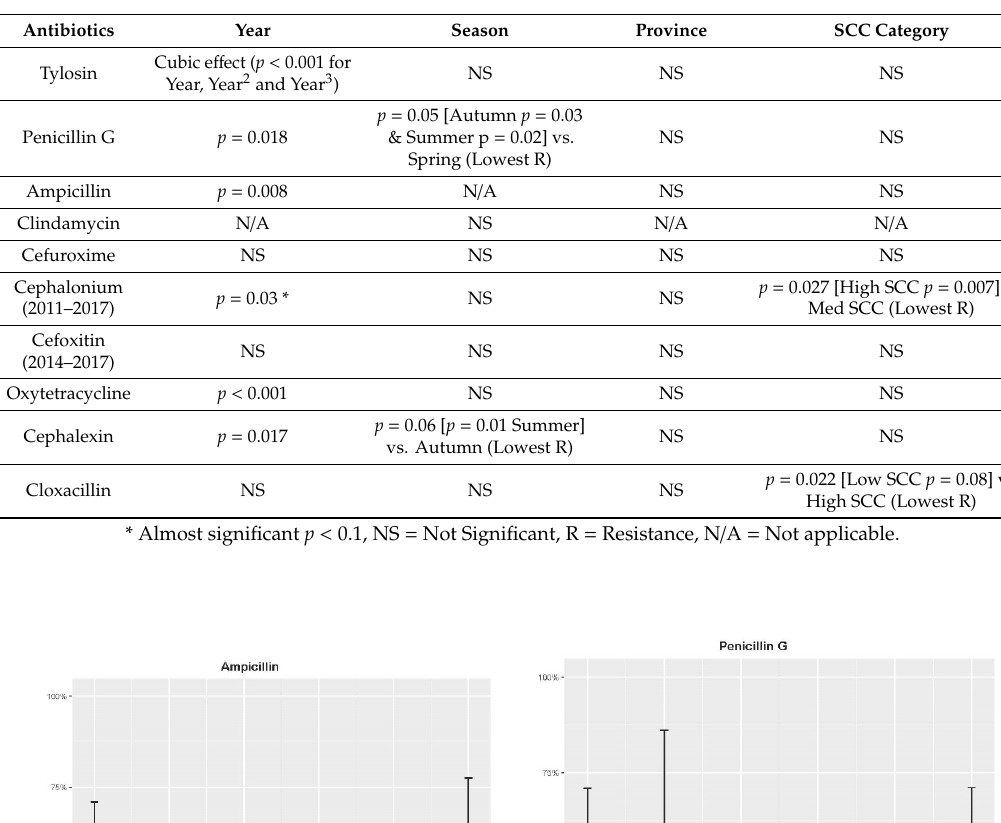
Table 1. Summary variables on antibiotic resistance e ff ects of GLMM for maltose-negative S. aureus , according to the CLSI breakpoints used [13].